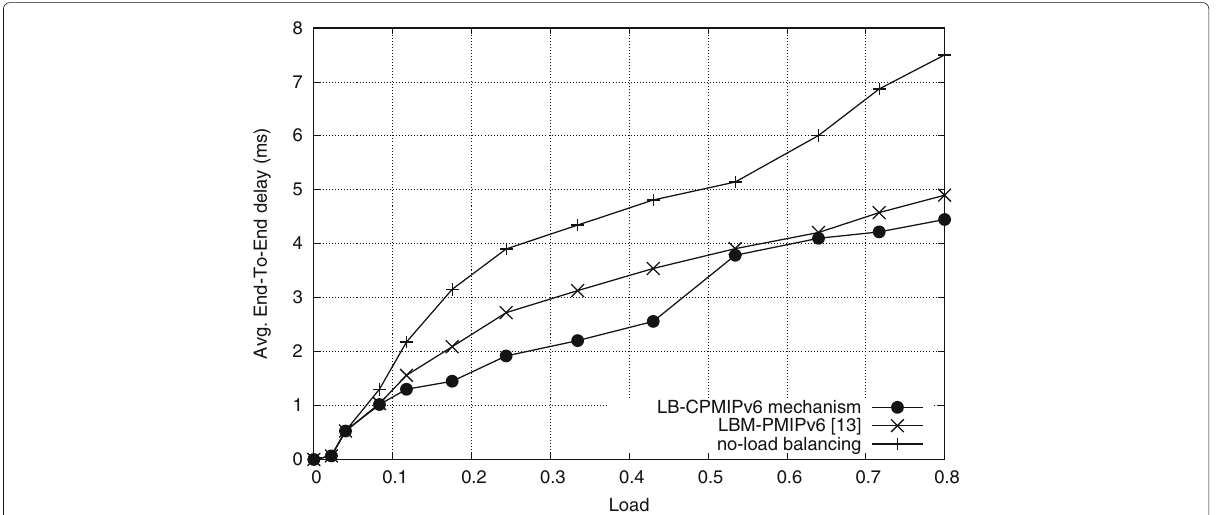
Fig. 18 End-to-end delay per MAG versus the total